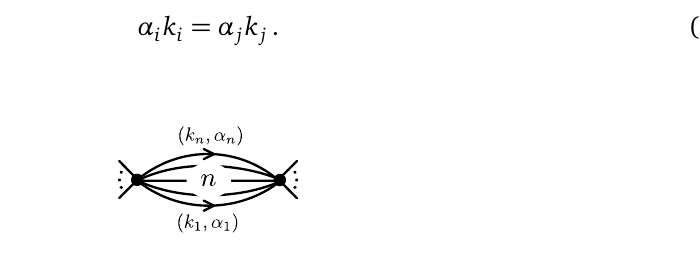
Figure 12: A bubble sub-graph with n internal lines. Each line is associated with an = m 2 and a Feynman parameter α on-shell momentum k 2 i forces them all to be the same, making the buble equivalent to a single line of mass n × m .